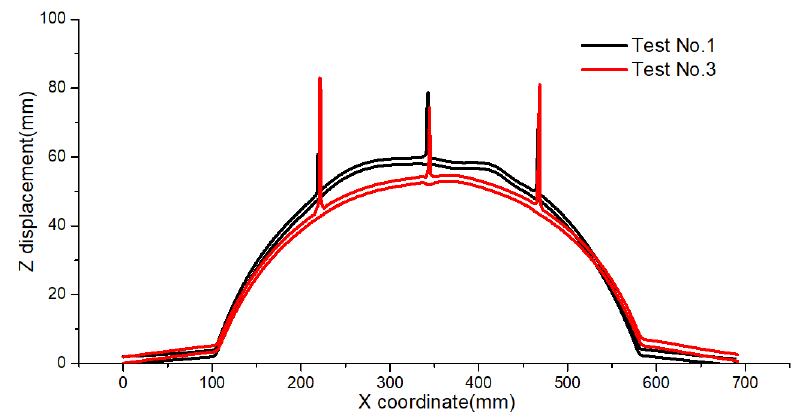
Figure 23. Central H-H section profile of Tests No. 1 and 3.